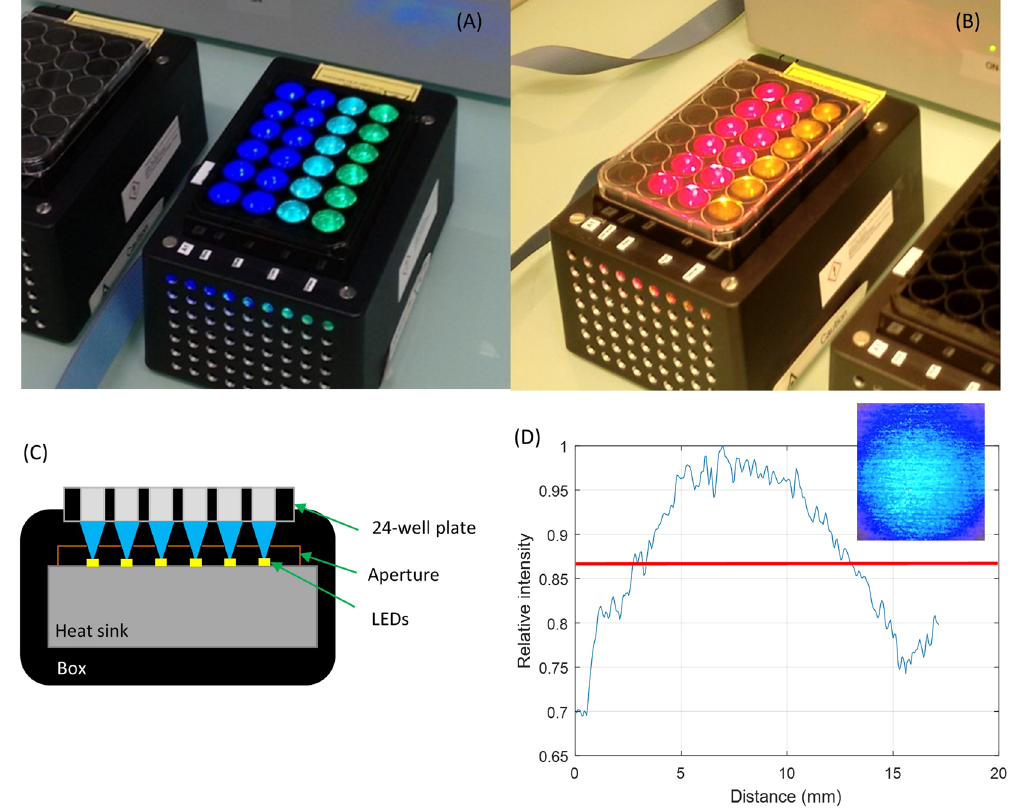
Figure 8. LED-based devices used in the experiments. ( A ) Photograph of sub-module 1 with the LEDs emitting 450, 500 and 530 nm wavelengths and ( B ) sub-module 2 with the LEDs emitting 590, 655 and 850 nm wavelengths. ( C ) Cross-section of the design a module, in the direction of a row of 6 wells of the 24-well plate ( D ) Typical profile of one single light beam in the axial x-y direction (at 450 nm) under one of the wells of the 24-well plate (the size of 1 well is 15 mm diameter) measured using a standard